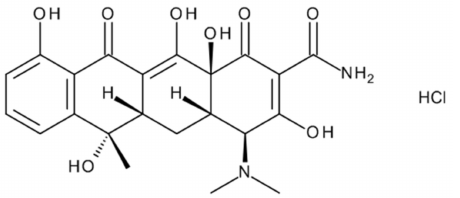
Figure 1. Chemical structure of tetracycline hydrochloride